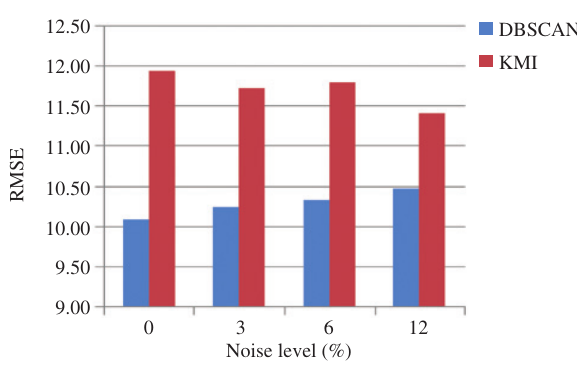
Figure 4: Average RMSE versus Noise Level for the 2D Data